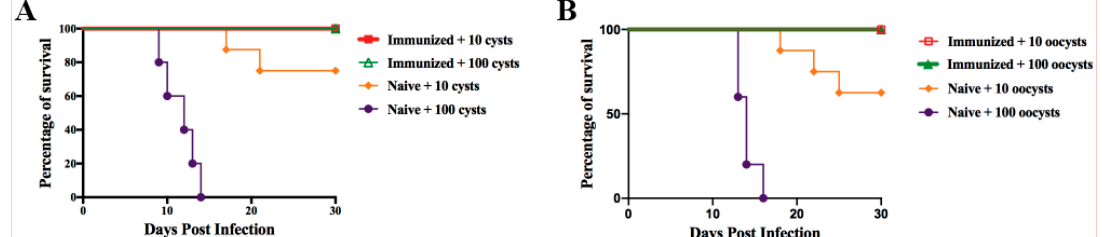
Figure 7. Protective e ff ect of RH ∆ gra17 ∆ npt1 vaccination against chronic T. gondii infection using tissue cysts or oocysts. Survival rates following challenge of RH ∆ gra17 ∆ npt1 -vaccinated mice with ( A ) 10 or 100 tissue cysts, or ( B ) 10 or 100 oocysts of type 2 Pru strain at 60 days post-vaccination over 30 days. All RH ∆ gra17 ∆ npt1 -vaccinated mice survived regardless of the inoculation dose or the parasite stage (cyst or oocyst) compared to naive mice. Eight mice per group were infected with 10 cysts or oocysts, and five mice per group were infected with 100 cysts or